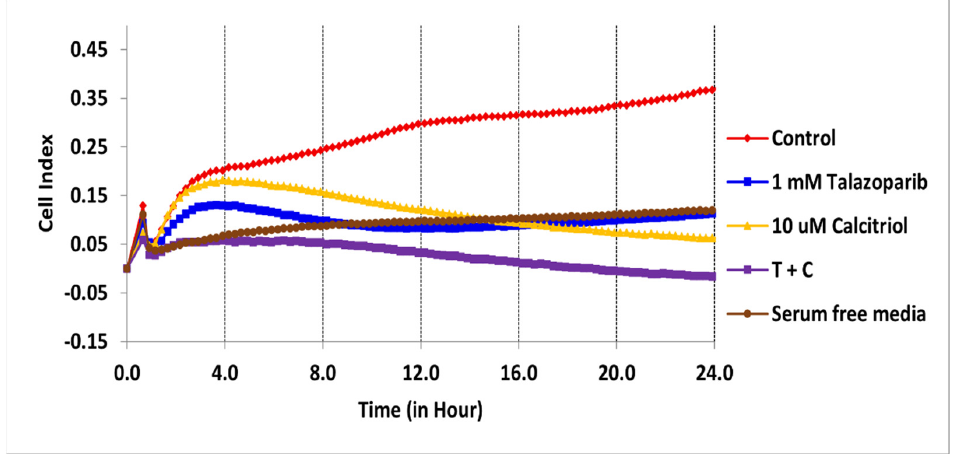
Figure 6. MDA − MB − 468 cell migration profiles. The experiment was performed in triplicate for each treatment. Real − time migration of MDA − MB − 468 cells, the slope represents the degree of cell migration (cell index) over time. Data are represented as the mean ± SD ( n = 3). The red color line is the untreated control. The brown color line is the negative control (serum − free media). Raw data and details of the statistical analysis can be found in Supplementary File S6 and Table S2, respectively.